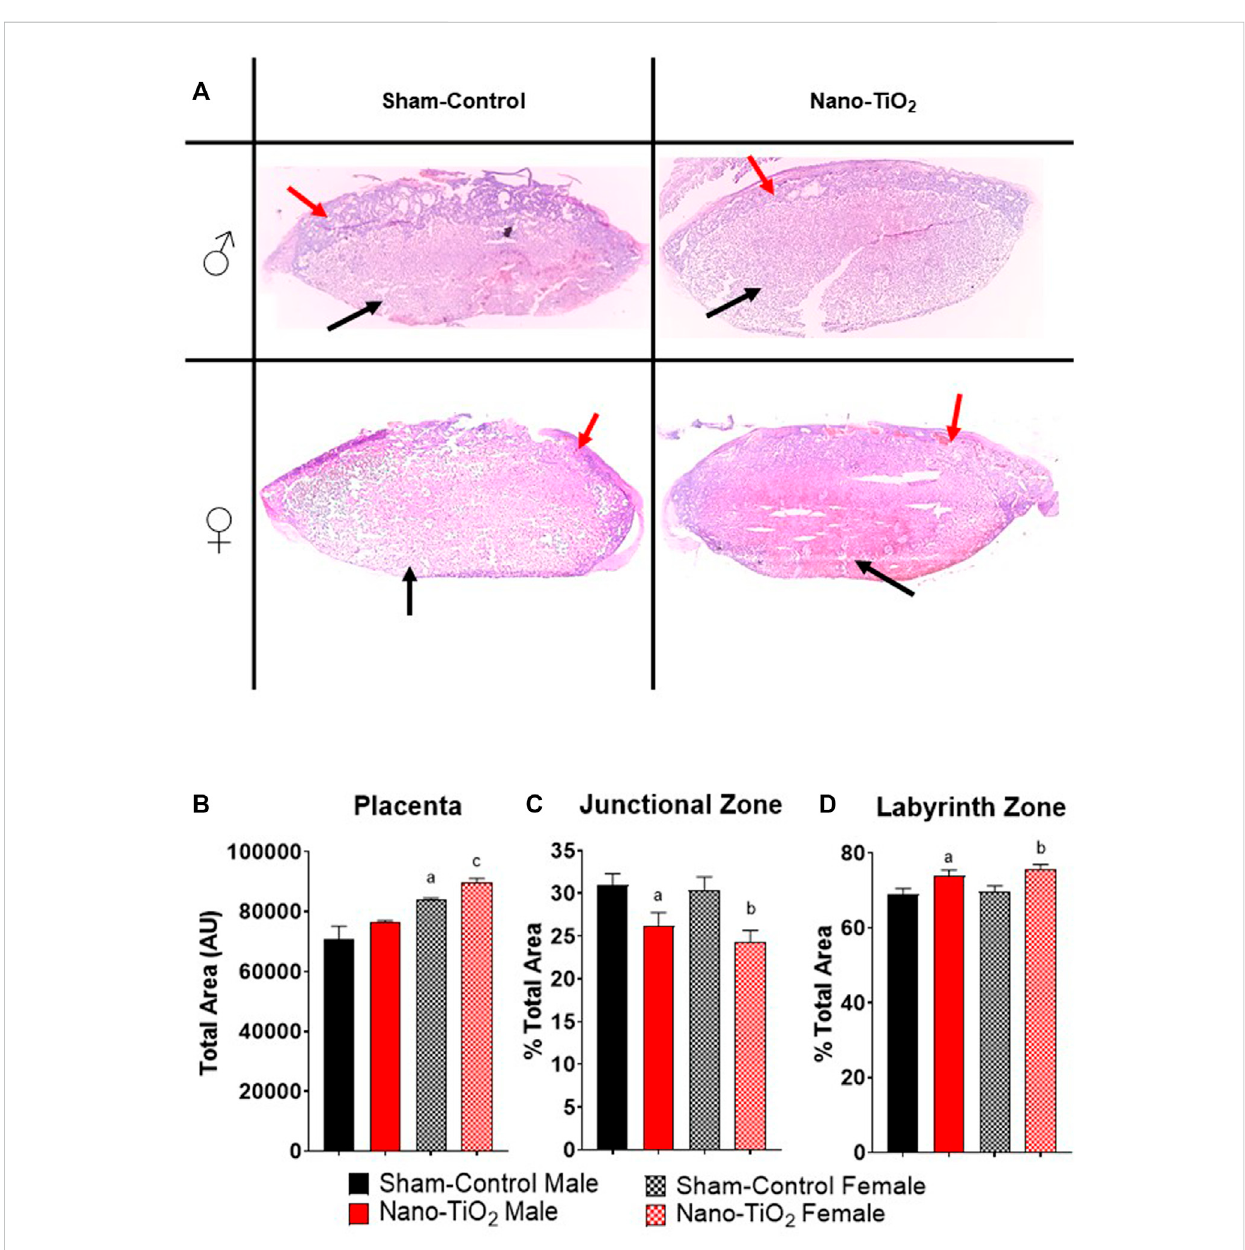
Placental Histology. Total placental zone areas were assessed after H&E staining to determine anatomical and structural differences after maternal nano-TiO 2 inhalation exposure. (A) Representative images of placenta histology are depicted for each group. (B) Total area of the placenta. (C) Percent total area of the junctional zone (JZ). (D) Percent total area of the labyrinth zone (LZ). Sham-control males (n = 5), sham-control females (n = 5),